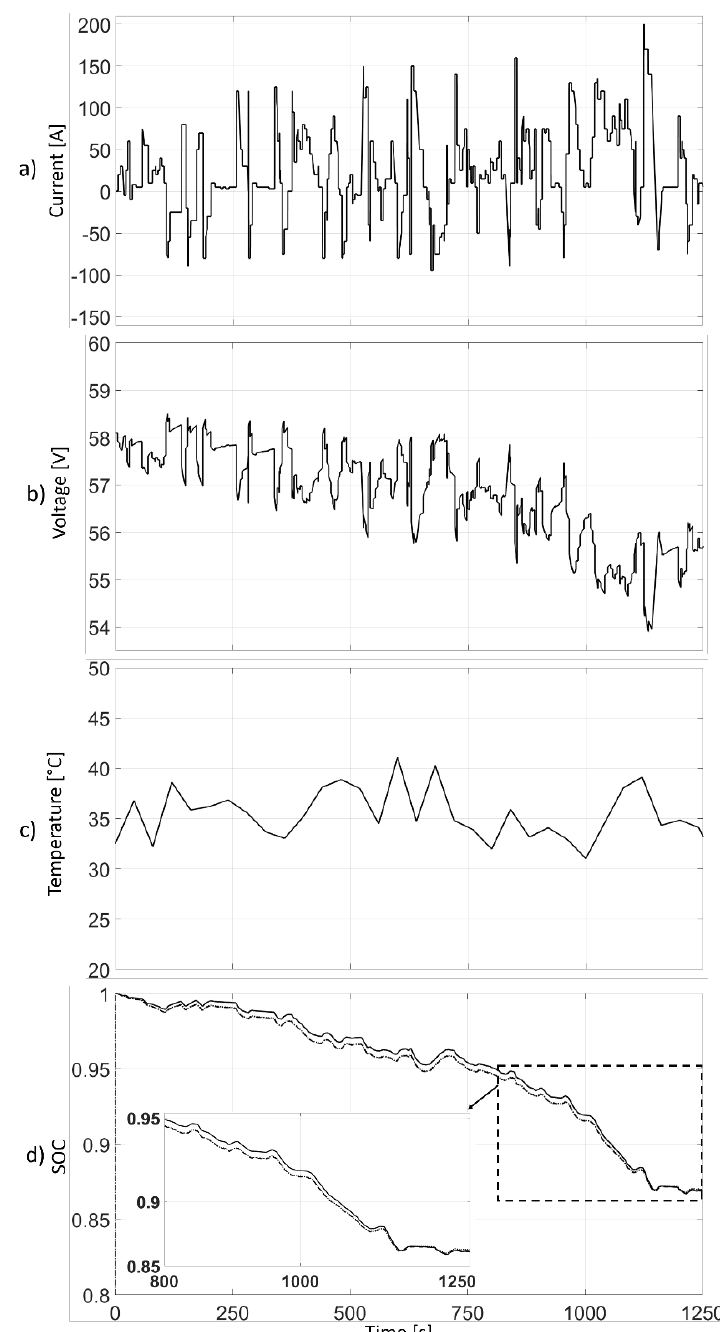
Figure 9. Validation on a real profile. ( a ) Current charge / discharge. ( b ) Voltage. ( c ) Temperature. ( d ) State of Charge: expected SOC (solid line), estimated SOC in simulation (dashed line) and estimated SOC on real electronic control unit (dash-dotted line).